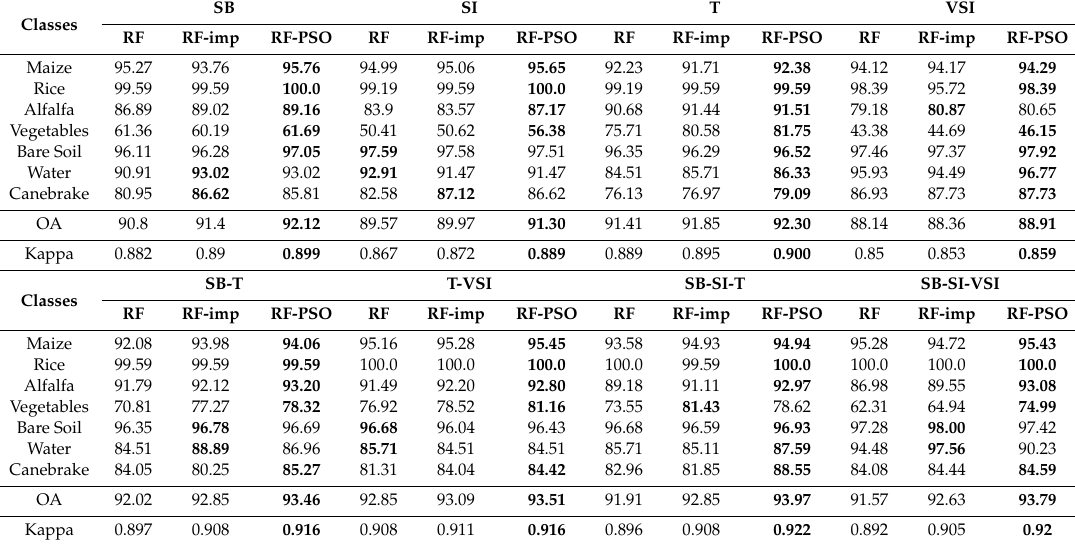
Table 5. F-score (%), overall accuracy (OA, %), and Kappa coe ffi cient of the impacts of feature selection on the classification accuracy in di ff erent feature sets. Bold values correspond to the highest F-scores, Kappa coe ffi cient, and